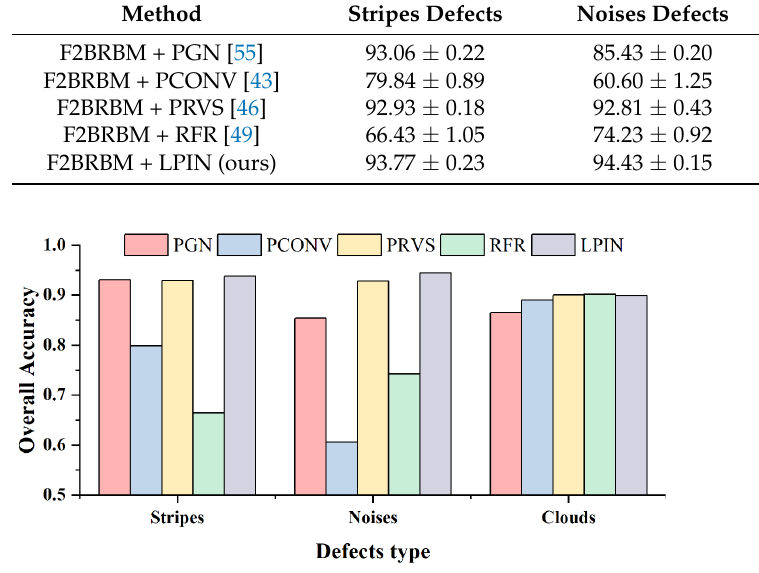
Table 5. OA Comparison of F2BRBM Combined with Different Inpainting Models on Images with Defects. Method Stripes Defects Noises Defects Clouds Defects